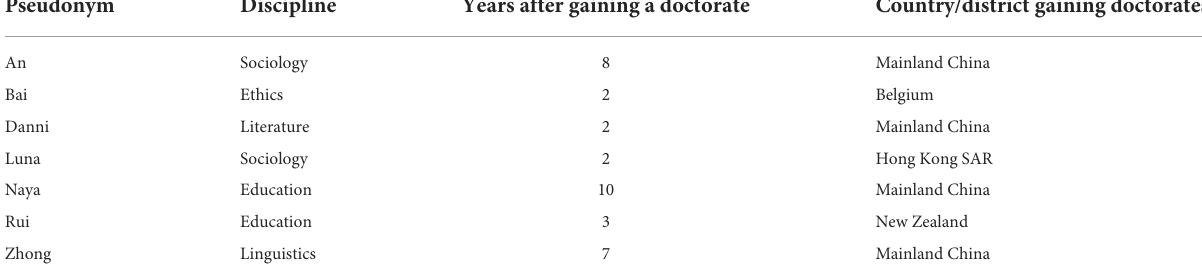
TABLE 1 Background of the